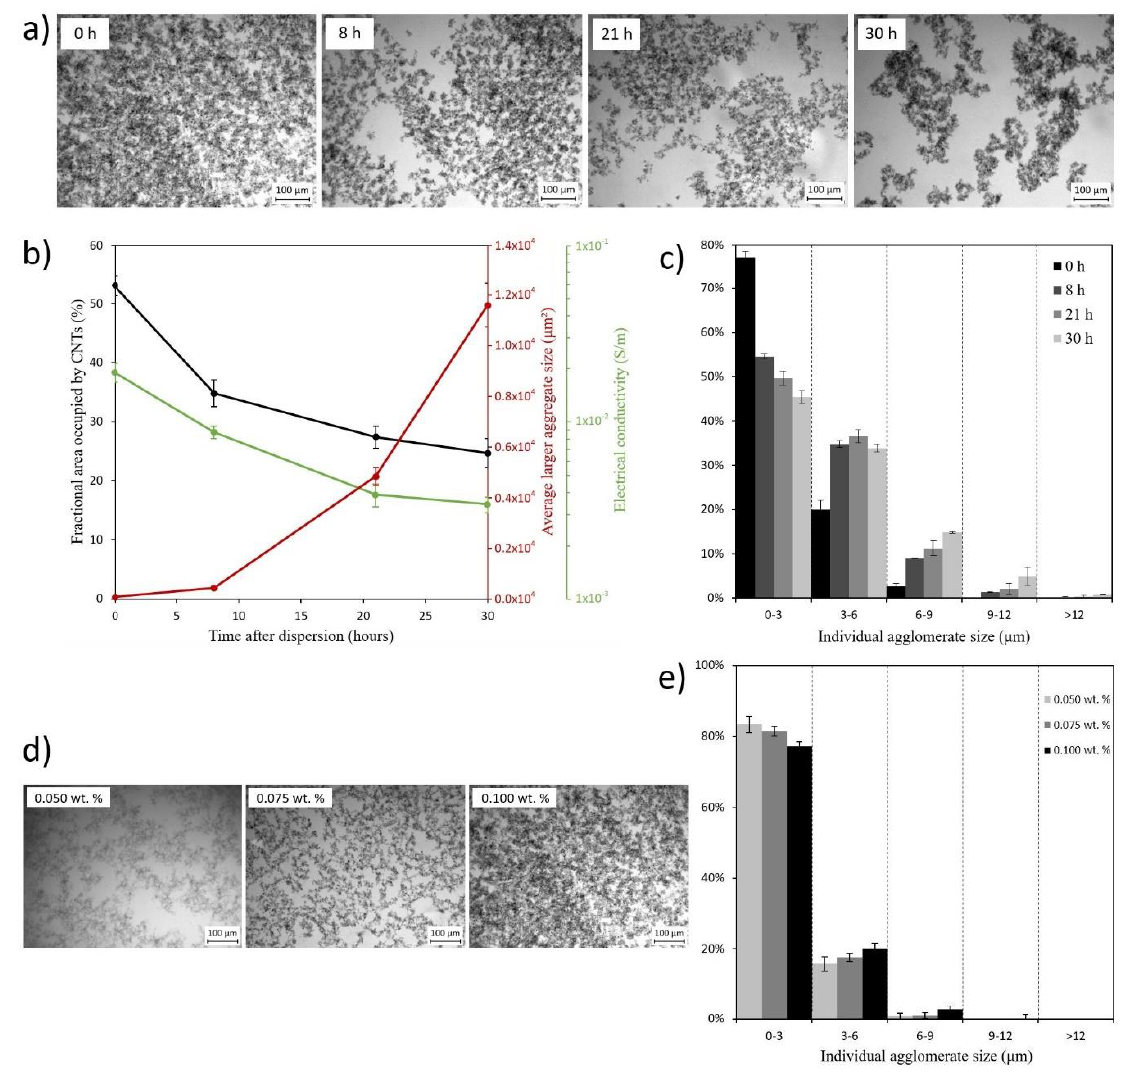
Figure 4. Changes on the dispersion state as a function of time after dispersion process was performed and as a function of CNT content. ( a ) TOM micrographs of dispersion containing 0.100 wt % CNT at 0, 8, 21, and 30 h after dispersion was carried out; ( b ) fractional area occupied by CNTs, average larger aggregate size and their influence in electrical conductivity as a function of time since after dispersion; ( c ) individual agglomerate size as a function of time after dispersion; ( d ) TOM micrographs at 0 h after dispersion as a function of CNT content; and ( e ) individual agglomerate size at 0 h after dispersion as a function of CNT content.